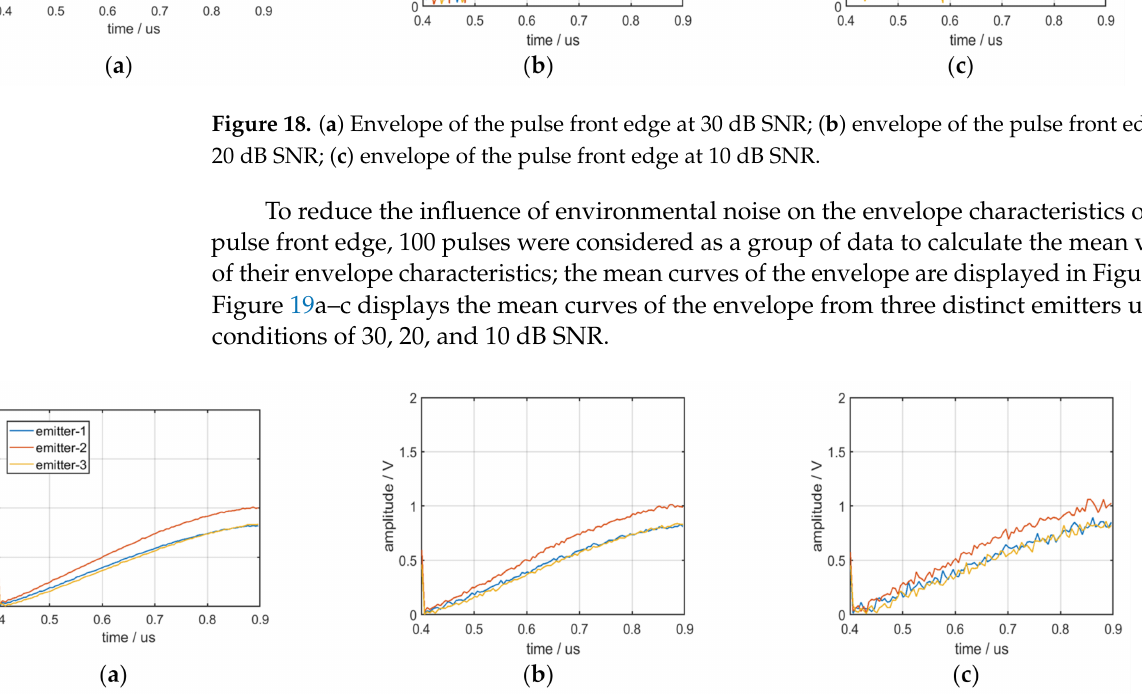
Figure 19. ( a ) Mean curves of the envelope at 30 dB SNR; ( b ) mean curves of the envelope at 20 dB SNR; ( c ) mean curves of the envelope at 10 dB